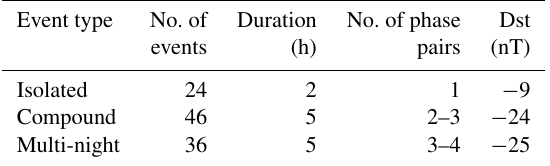
Table 1. A selection of descriptive parameters to characterize the different substorm